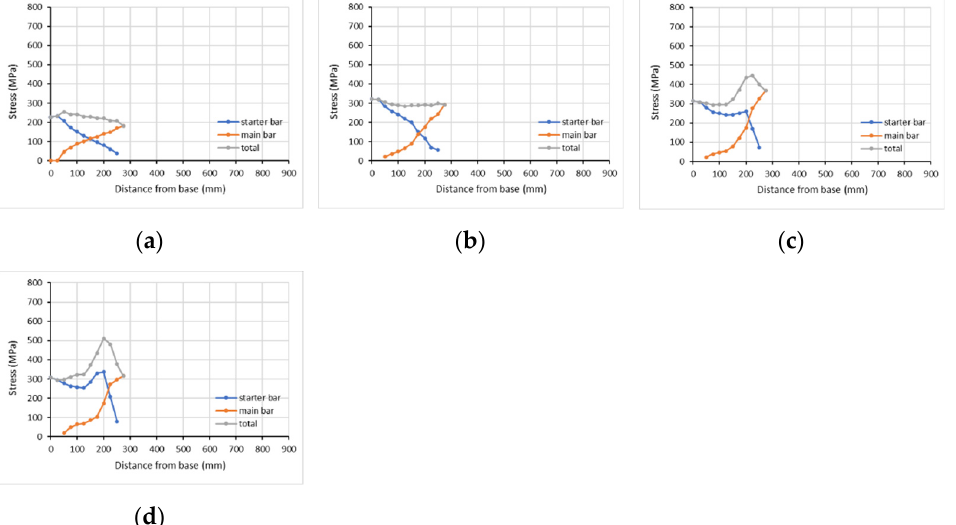
Figure 17. Developed stress along lap splice length at a displacement of ( a ) 3.15 mm, ( b ) 8.57 mm ( δ py ), ( c ) 16.95 mm ( δ Pmax ), and ( d ) 28.50 mm ( δ u ), for column R-0L1.